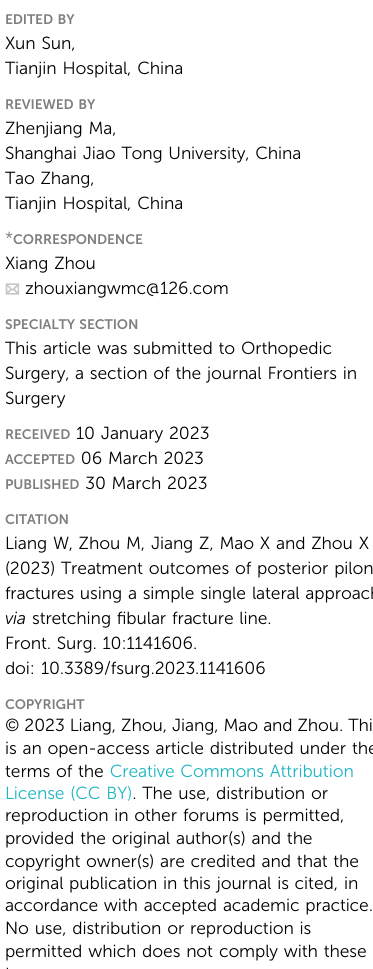
via stretching fi bular fracture